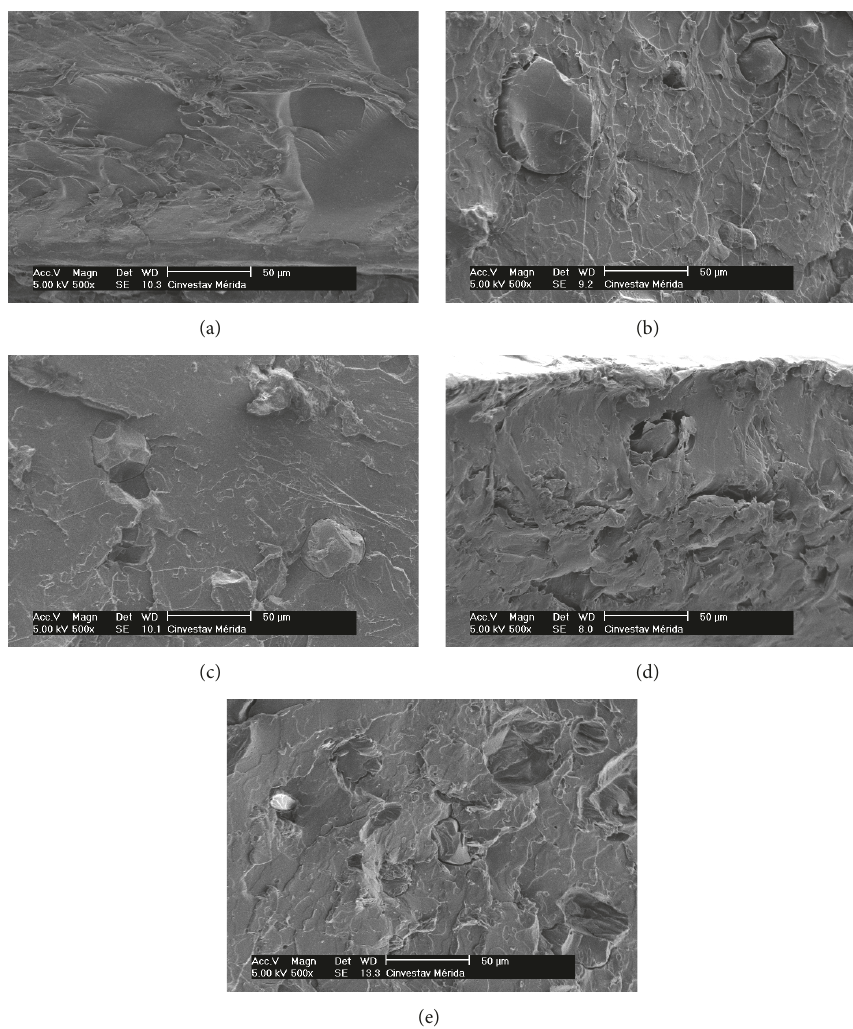
Figure 10: Morphology of fracture surface of PLA-PNSP biocomposites at 500x magnification: (a) neat PLA, (b) 5% wt. PNSP defatted, (c) 5% wt. PNSP untreated, (d) 7.5% wt. PNSP defatted, and (e) 7.5% wt. PNSP